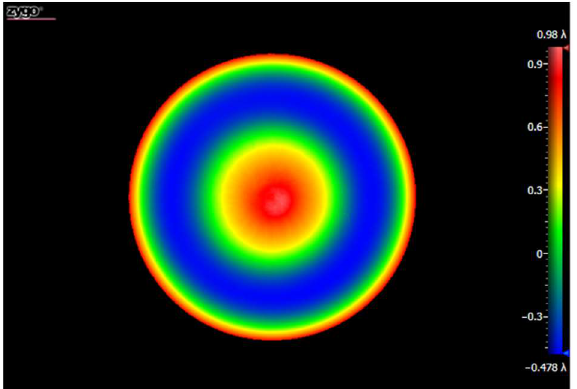
Figure 11. Full-aperture figure error of the spherical SUT.